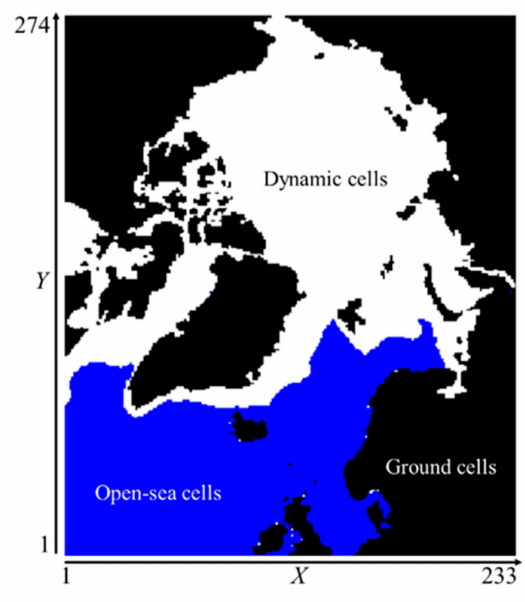
Figure 1. Dynamic, open-sea, and ground